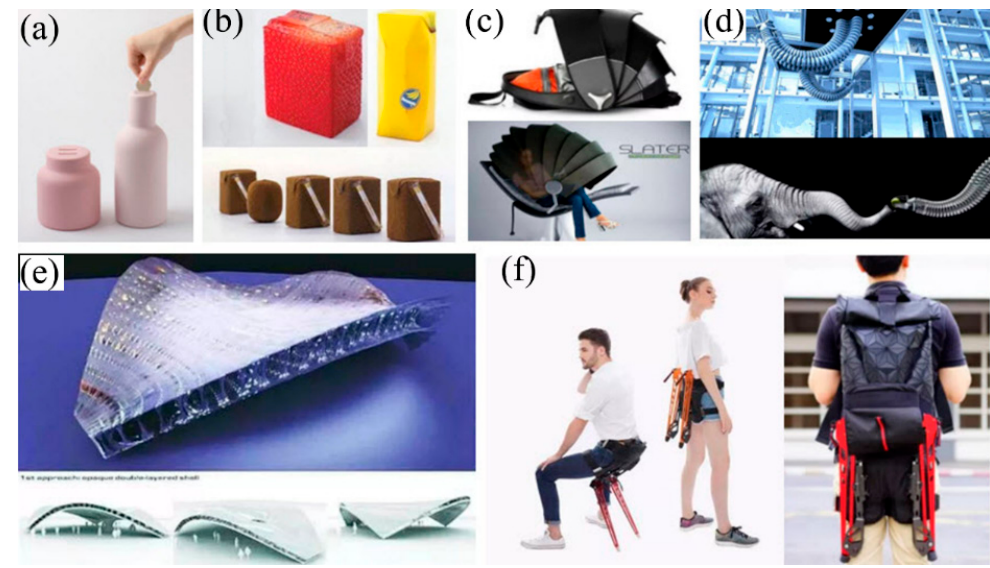
Figure 4. The application of bionics in product design, ( a ) Peggy money jar (https://mp.weixin.qq.com/s/Utcnq2I7jw1DGjhA7eHc-Q (accessed on 5 August 2018)), ( b ) MUJI juice box (https://mp.weixin.qq.com/s/cBDQjeHmo2WESun052nQlw (accessed on 9 June 2020)), ( c ) pangolin backpack (https://mp.weixin.qq.com/s/zgvb2ORflXOgIw5Fo-1nOw (accessed on 17 March 2015)), ( d ) Festo robotic arm (https://mp.weixin.qq.com/s/wxKwO21wV4kp-oT2AZqB2w (accessed on 12 September 2021)), ( e ) energy efficient biological building materials for the bionic bird skull structure (https://mp.weixin.qq.com/s/1qN4fwEtKdzyd2J67EZ_2A (accessed on 26 July 2016)), and ( f ) LEX wearable bionic chair (https://mp.weixin.qq.com/s/BNOTrEP_heiY-EWJEBfbGA (accessed on 7 December